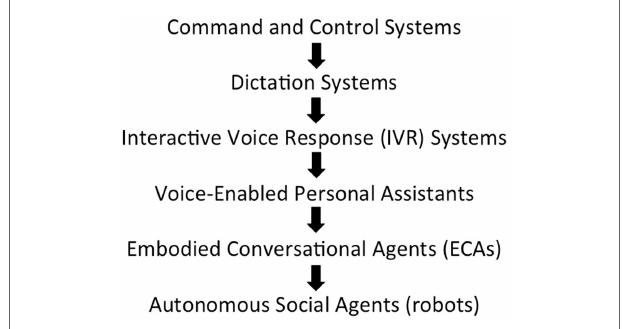
FiGURe 2 | The evolution of spoken language technology from early military “Command and Control Systems” through current “voice-enabled Personal Assistants” (such as Siri ) to future “Autonomous Social Agents” (e.g., robots)